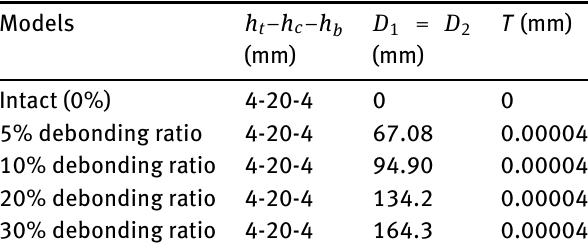
Table 1: Sandwich configuration and debonding geometry.